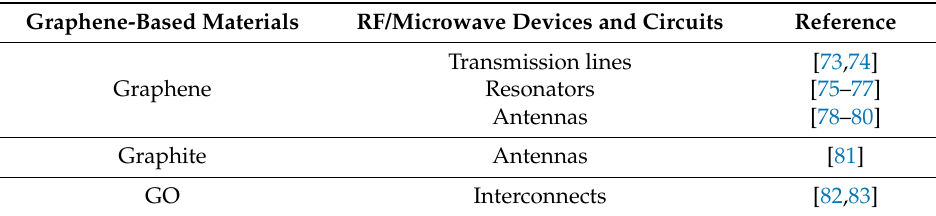
Table 2. RF/microwave devices and circuits of graphene